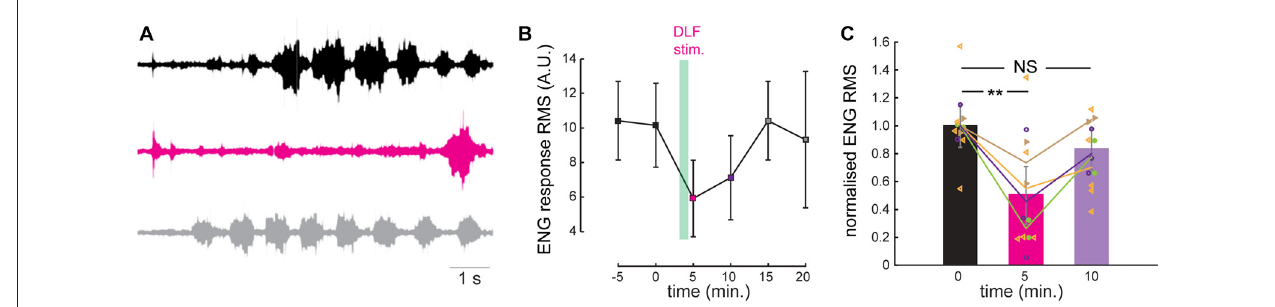
FIGURE 3 | A prolonged stimulation of the DLF inhibits the scratch reflex. (A) Electroneurogram (ENG) of a hip flexor nerve during scratch reflex evoked by mechanical stimulation of the skin. Upper trace (black): control reflex. Middle trace (purple): scratch reflex evoked shortly after a 1 min stimulation of the DLF at 5 Hz. Lower trace (gray): recovery recorded 5 min after the beginning of DLF stimulation. (B) Time course of the effect induced by DLF stimulation. Scratch amplitude quantified by calculating the root-mean-square (RMS) of the ENG during full scratch episodes. DLF stimulation produced a strong and reversible inhibition of the scratch reflex (individual points are the average of 2 or 3 trials). (C) Comparison of the normalized ENG amplitude for all the preparations used for the study ( n = 4) in control conditions, after DLF stimulation and after recovery. Significant inhibition induced by DLF. ∗∗ p <